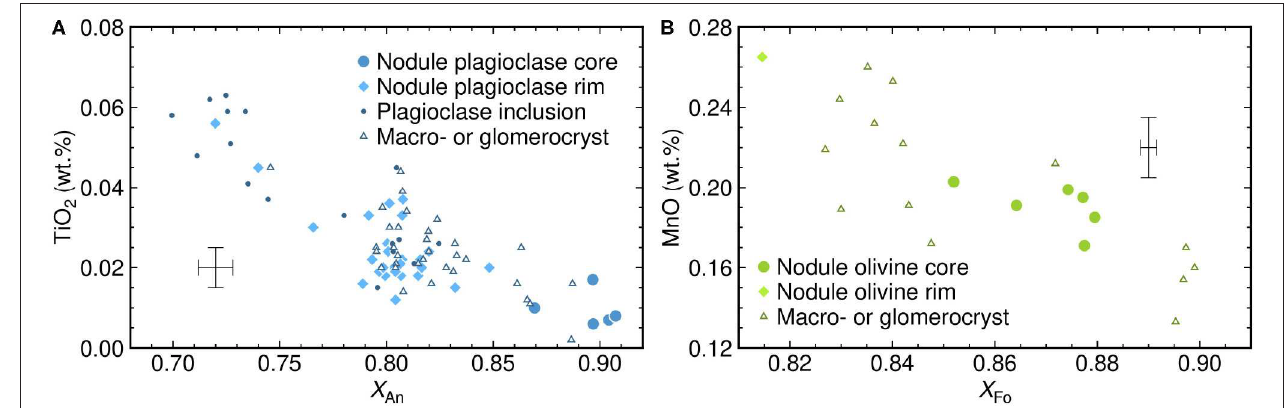
FIGURE 4 | Plagioclase and olivine compositions in sample JM27 from the Borgarhraun lava flow in North Iceland. (A) Plagioclase compositions summarized in terms of X An [where X An molar Ca/(Ca+Na)] and TiO 2 . Analyses are divided into four textural associations: nodule cores, nodule rims, inclusions, and macrocrysts or = glomerocrysts. 2 σ analytical uncertainties based on repeat measurements of the Lake County plagioclase (NMNH 115900) are shown (Jarosewich et al., 1980). (B) Olivine compositions summarized in terms of X Fo [where X Fo molar Mg/(Mg+Fe)] and MnO. Analyses are divided into three textural associations: nodule cores, = nodule rims, and macrocrysts or glomerocrysts. 2 σ analytical uncertainties based on repeat measurements of the San Carlos olivine (NMNH 111312-44) are shown (Jarosewich et al.,